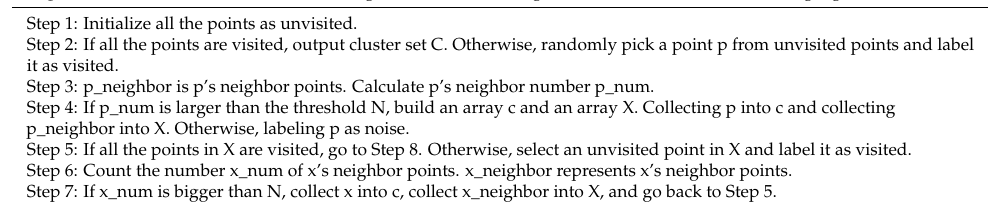
Algorithm 1: Center coordinate detection algorithm via combining classification model and clustering